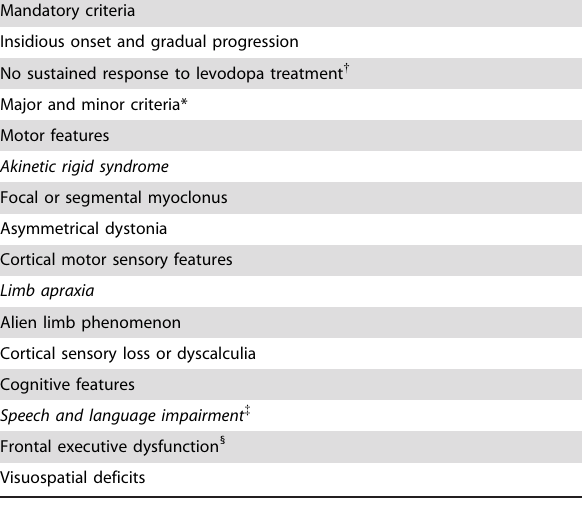
Table 1. Proposed criteria for the diagnosis of